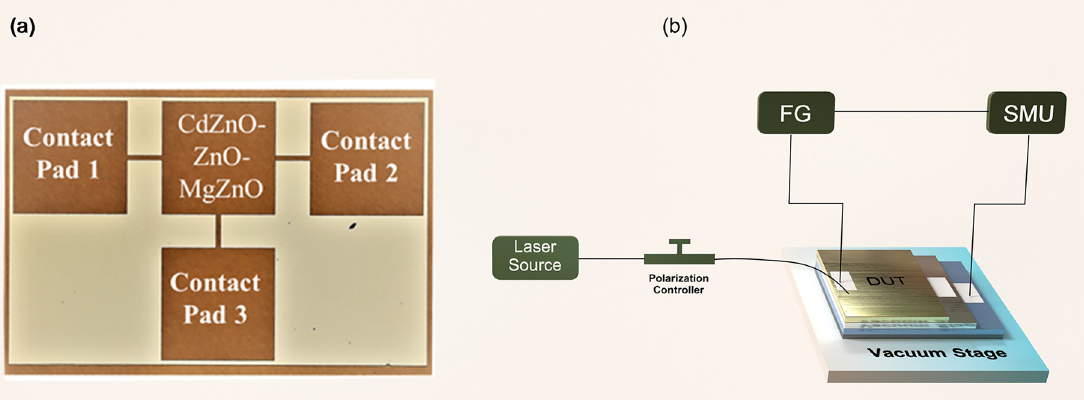
Figure 2: (a) Optical image of the fabricated device. CdZnO – ZnO – MgZnO layer deposited over each other and connected to an individual contact pad. (b) Setup for opto-electronic characterization of the device under test (DUT). Both the junctions are biased using signal measurement unit (SMU) and function generator (FG) and optically excited with photonic energies from 0.8 to 1.87 eV using different laser source.